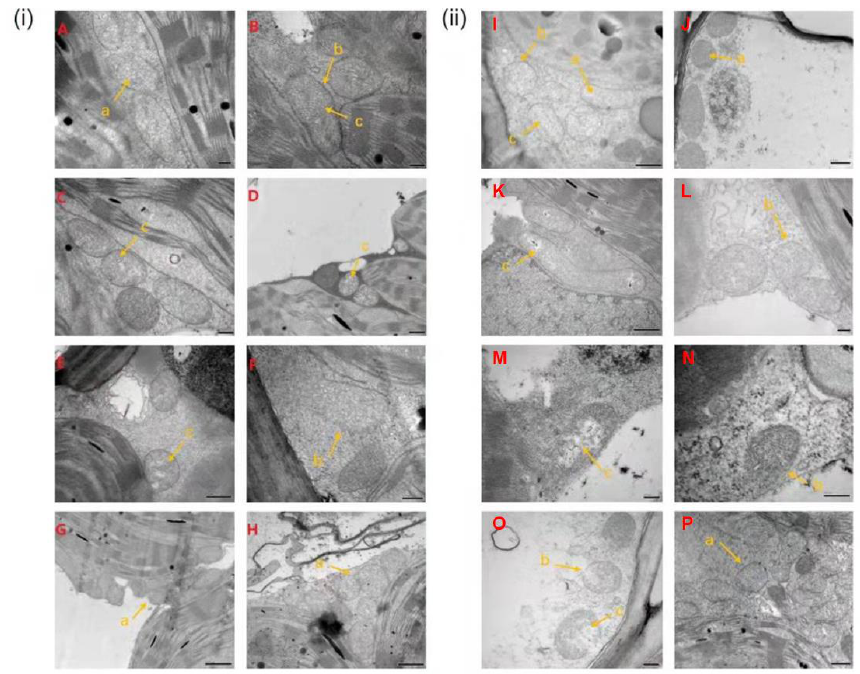
Figure 4. Mitochondrial changes in rust-resistant Z. japonica (RR) and rust-susceptible Z. japonica (RS) after inoculation with P. zoysiae . ( i ) Inoculated RR leaves; ( ii ) Inoculated h RS leaves; ( A , I ) Non-inoculation; ( B , J ) 1 day post inoculation (dpi); ( C , K ) 3 dpi; ( D , L ) 5 dpi; ( E , M ) 8 dpi; ( F , N ) 10 dpi; ( G , O ) 15 dpi; ( H , P ) 20 dpi. (a) mitochondria; (b) mitochondrial membrane; (c) cristae.